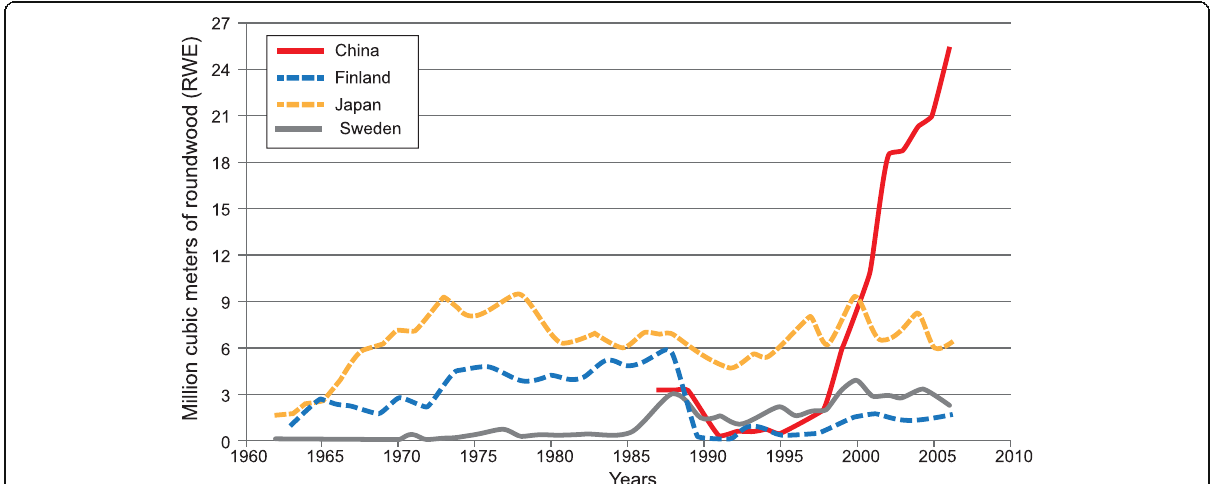
Fig. 12 Major export markets for Russian forest products 1960 — 2009 (archive of Newell and Simeone 2014; data source European Forest Institute